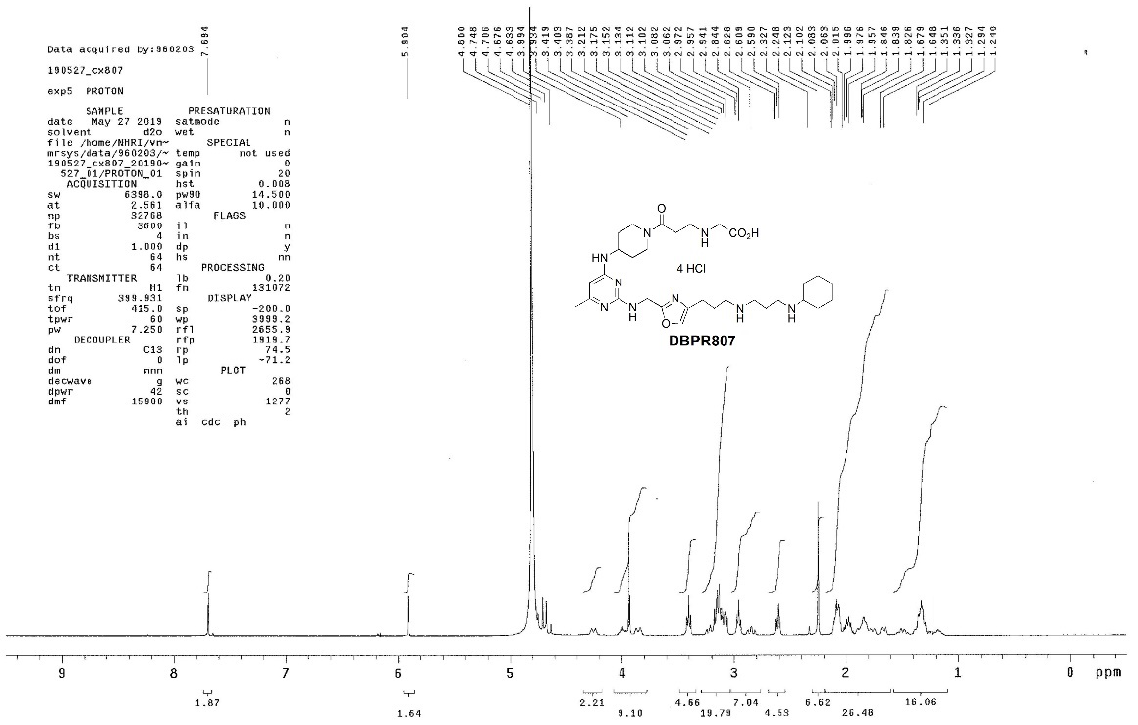
Figure A1. Structural characterization of DBPR807 with 1 H NMR spectral analysis.